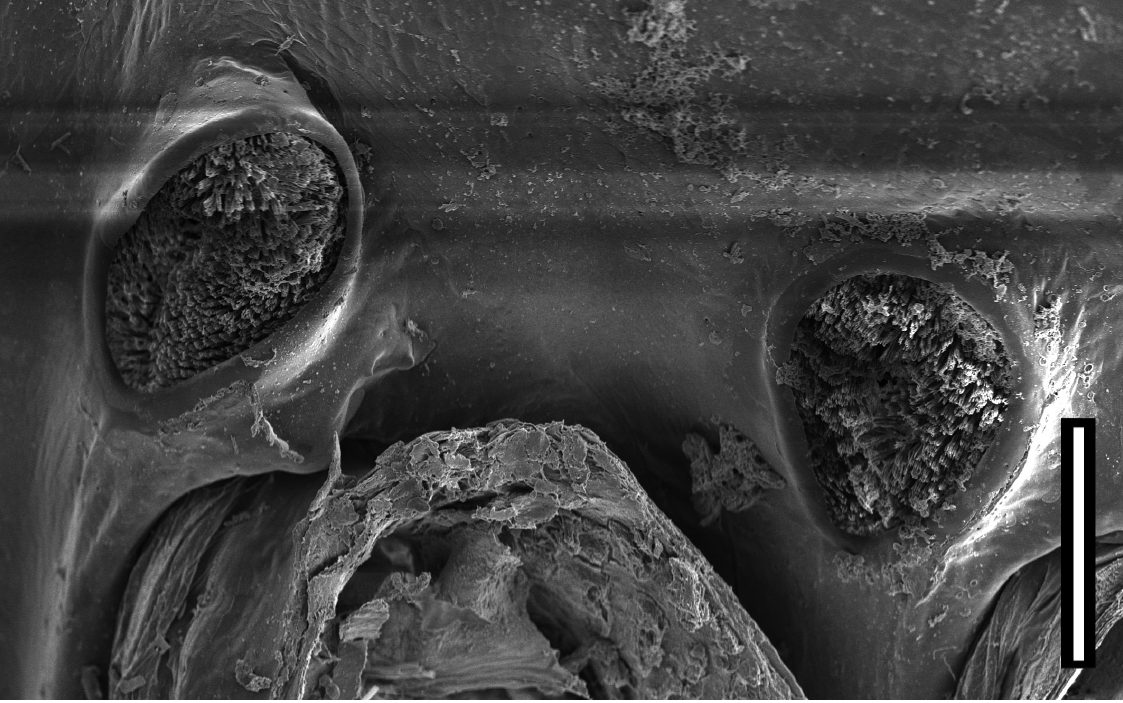
Fig. 21. Pogonosternum jeekeli Decker, sp. nov., ♂, spiracles, midbody ring, left lateral side (QM 23:15360). Scale bar: 0.1